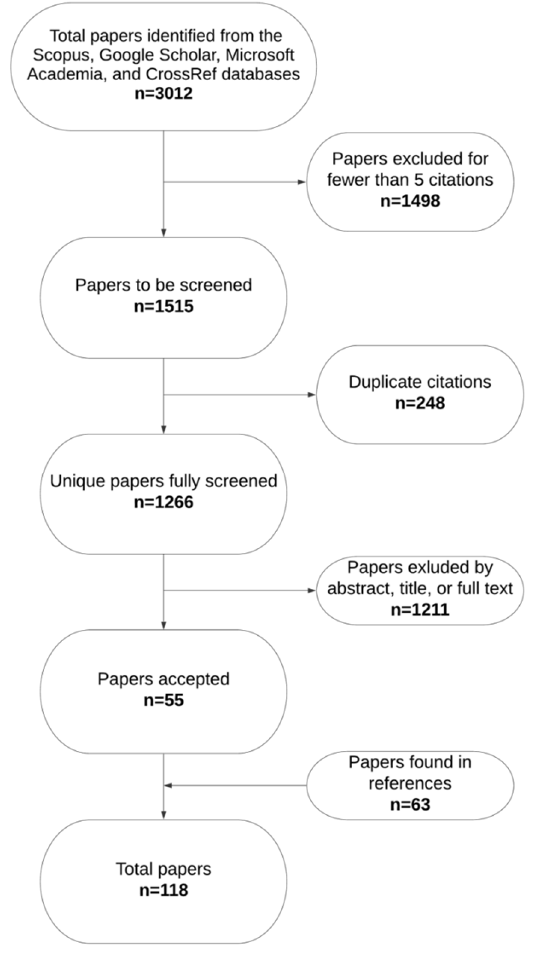
Figure 1. The number of papers included/excluded at each stage in the screening phase of this literature review. The full list of papers reviewed and characterized can be found in Supplementary Material Table S1.